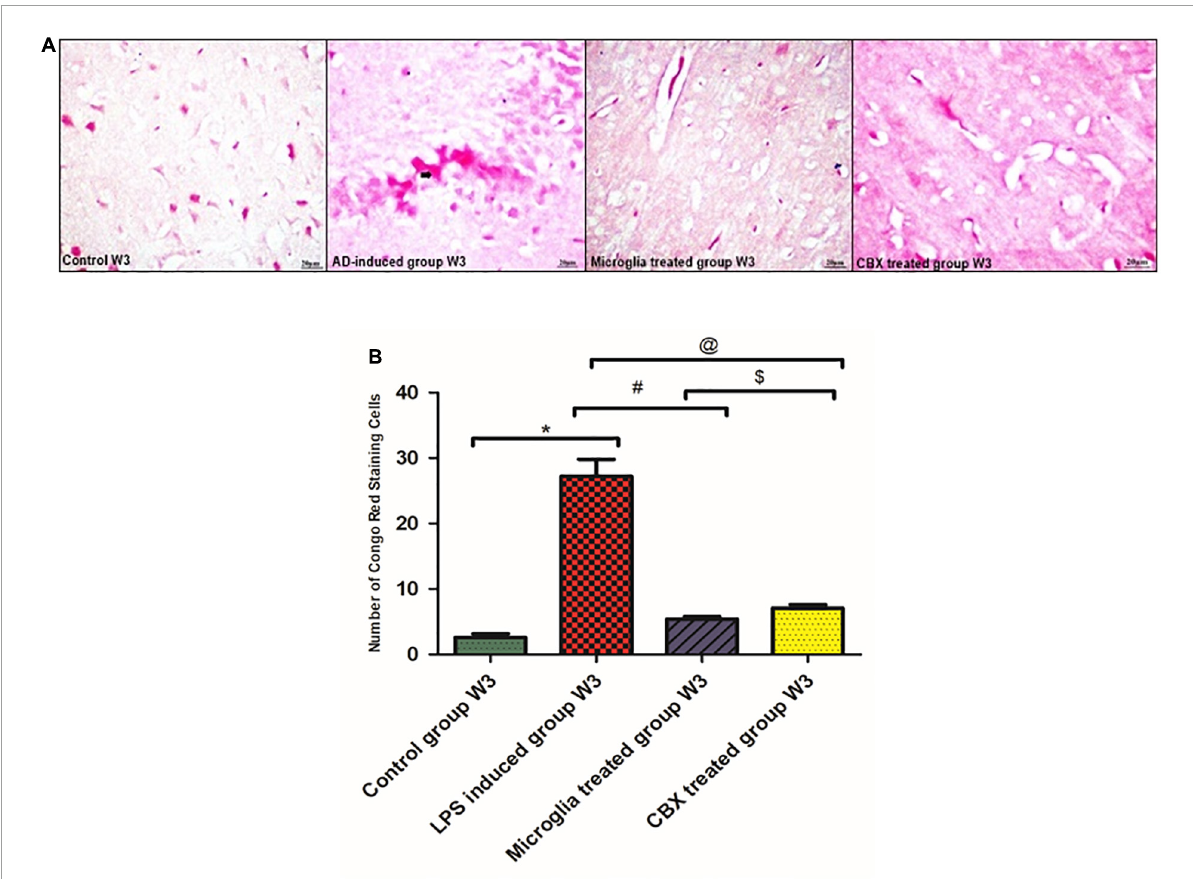
FIGURE6 Illustration of Congo red (CR)-stained brain sections of the lipopolysaccharide (LPS)-induced rats and following the intracerebroventricular (ICV) administration of primary healthy microglia (PHM) and carbenoxolone (CBX) in week 3 for the visualization of A β . (A) Illustrative images of positive A β hallmark depositions stained by CR in the LPS-induced AD neuroinflammatory model and following the single ICV administration of PHM and CBX (week 3). (B) Number of CR positively stained cells, where the observed stained A β cells were counted under the light microscope. Represented data were expressed as mean ± SD ( n = 6 per group) (ANOVA, repeated measurement, Bonferroni post-hoc test, p < 0.05). The same asterisks represent an insignificant difference p > 0.05.